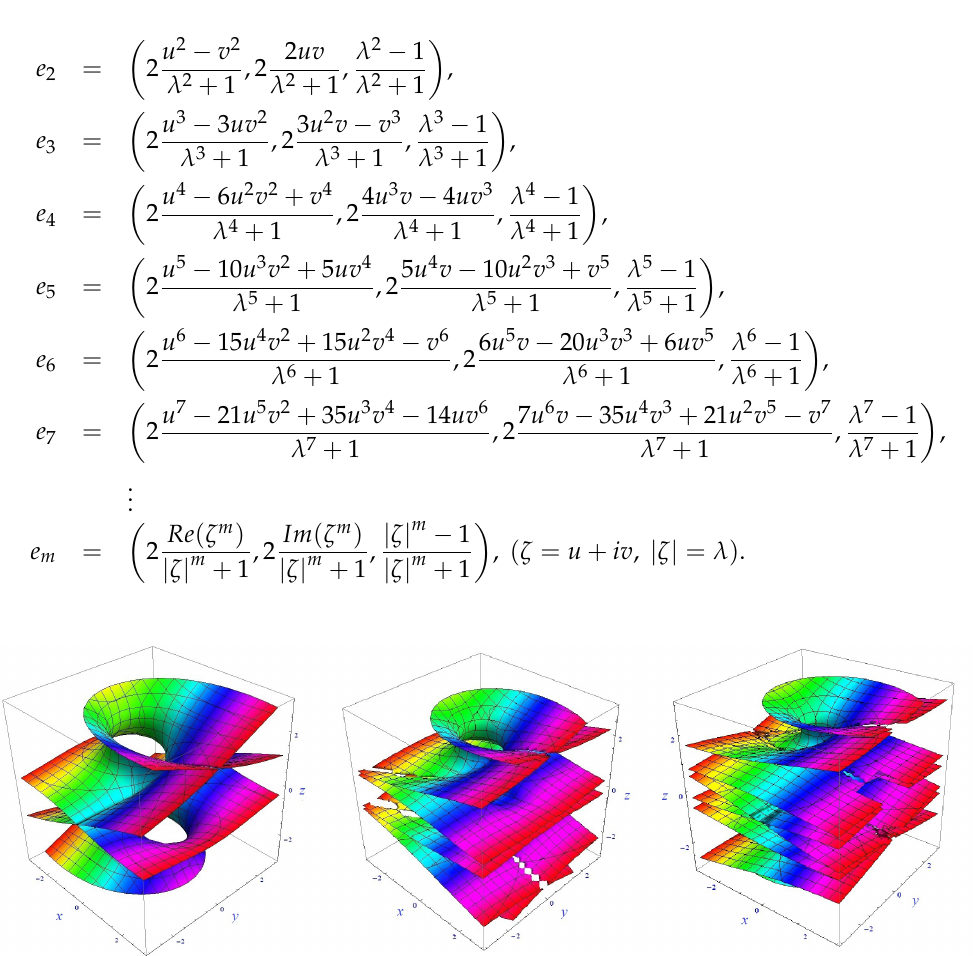
Figure 2. Algebraic minimal surfaces ( Left ) Q 2 ( x , y , z ) = 0, ( Middle ) Q 3 ( x , y , z ) = 0, ( Right ) Q 4 ( x , y , z ) = 0.